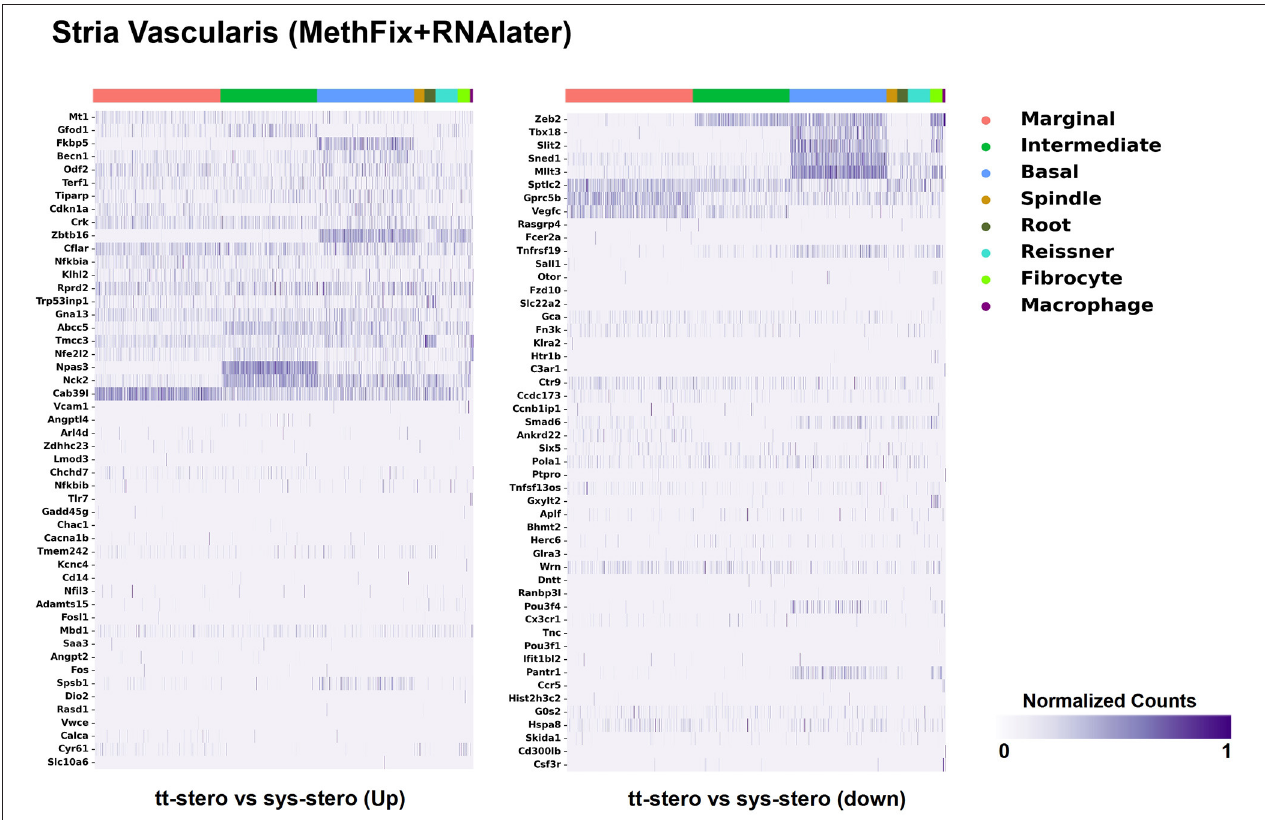
FIGURE 1 | Steroid-responsive gene expression in the adult mouse stria vascularis after treatment with transtympanic vs. systemic steroids. Expression of steroid-responsive genes from mice treated with transtympanic vs. systemic steroids ( 14) in an adult mouse stria vascularis (SV) single-nucleus RNA-Seq dataset (16). Heatmap (LEFT) localizes genes with increased expression in mice treated with transtympanic vs. systemic steroids to cell types in the adult mouse SV. Heatmap (RIGHT) localizes genes with decreased expression in mice treated with transtympanic vs. systemic steroids to cell types in the adult mouse SV. Heatmaps display cells along the horizontal axis with cell types grouped by color with each bar denoting a single cell and genes are displayed along the vertical axis. The darker the bar, the more highly expressed the gene is in a given cell. Expression level is displayed in normalized